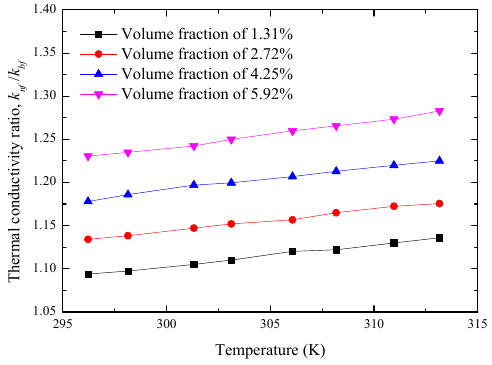
Figure 9. Variations of / nf bf k k with temperature for different nanoparticle volume fractions of Al 2 O 3 -water nanofluids.